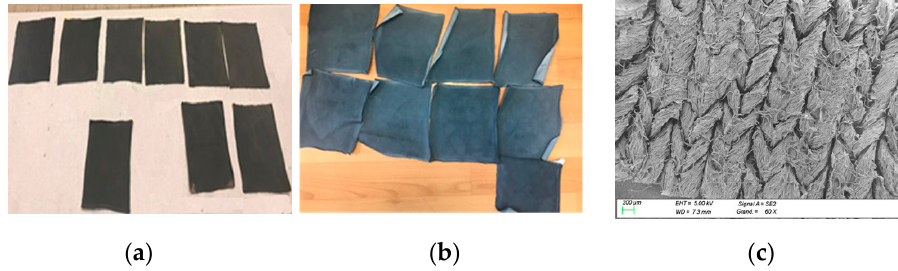
Figure 2. ( a ) cotton/Lycra; ( b ) 100% cotton single jersey electrodes coated by PEDOT:PSS. ( c ) SEM image for cotton single jersey electrode coated by PEDOT:PSS.